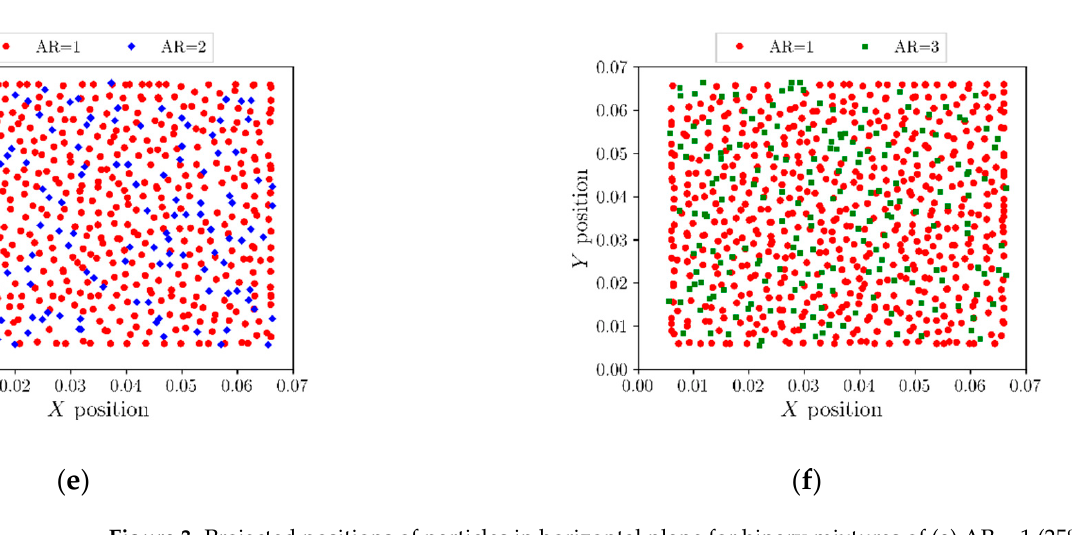
Figure 3. Projected positions of particles in horizontal plane for binary mixtures of ( a ) AR = 1 (25%) and AR = 2 (75%), ( b ) AR = 1 (25%) and AR = 3 (75%), ( c ) AR = 1 (50%) and AR = 2 (50%), ( d ) AR = 1 (50%) and AR = 3 (50%), ( e ) AR = 1 (75%) and AR = 2 (25%) and ( f ) AR = 1 (75%) and AR = 3 (25%).